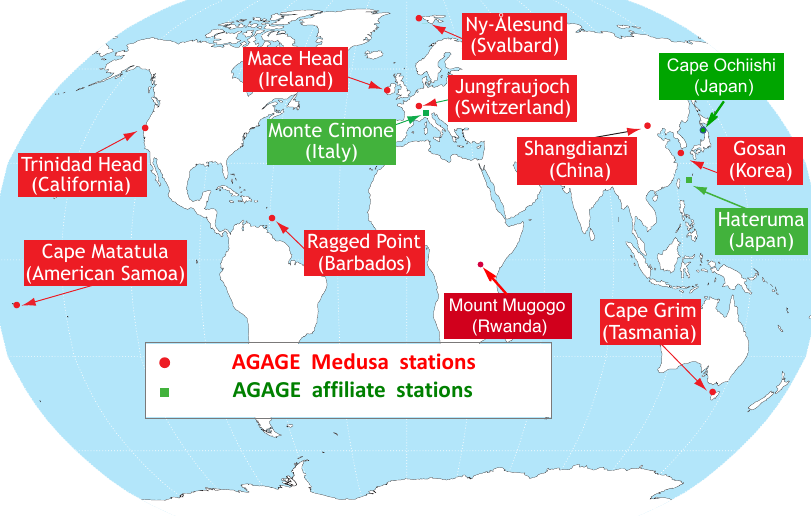
Figure 1. Locations of the 10 current AGAGE primary stations (red highlighted stations) that have Medusa gas chromatograph–mass spec- trometer (GC-MS) instruments and the 3 current AGAGE affiliate stations (green highlighted stations) that have alternative pre-concentration GC-MS instruments. AGAGE and the other major global air sampling network, NOAA-ESRL-GMD, are independent but closely cooperat- ing, including frequent data intercomparisons, especially at the American Samoa shared